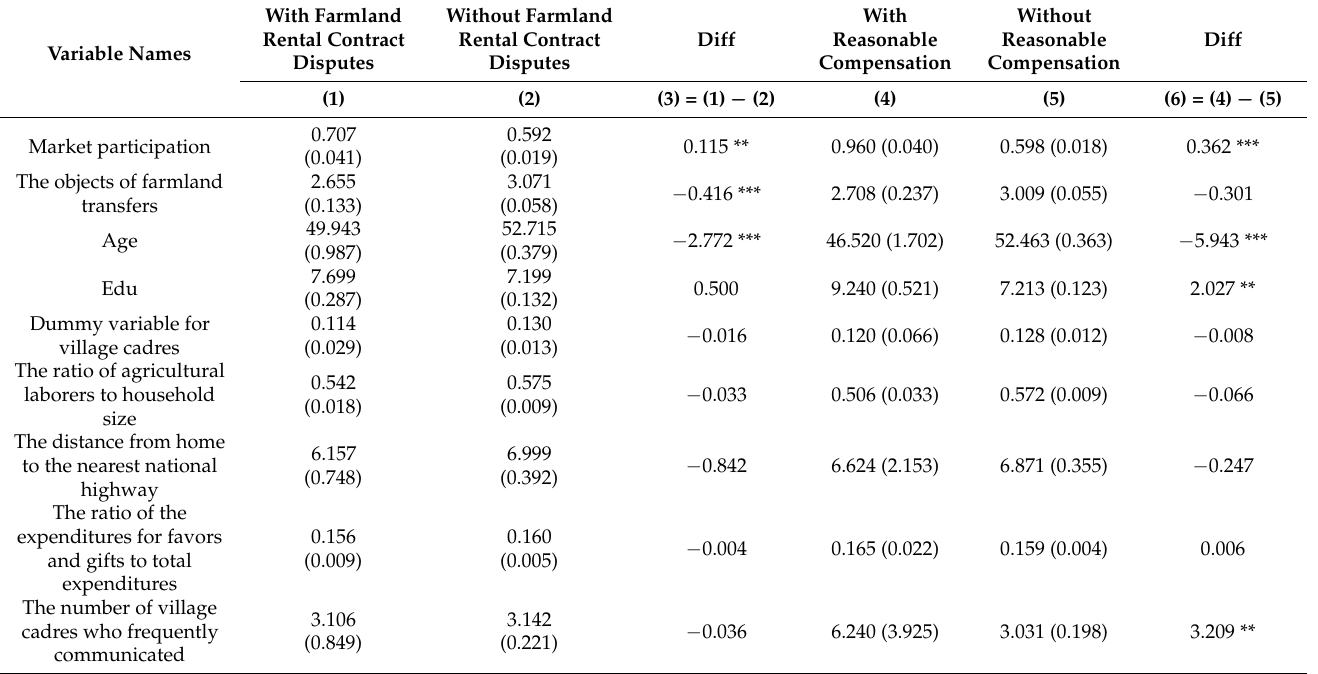
Table 2. The differences in farmland transfers and household